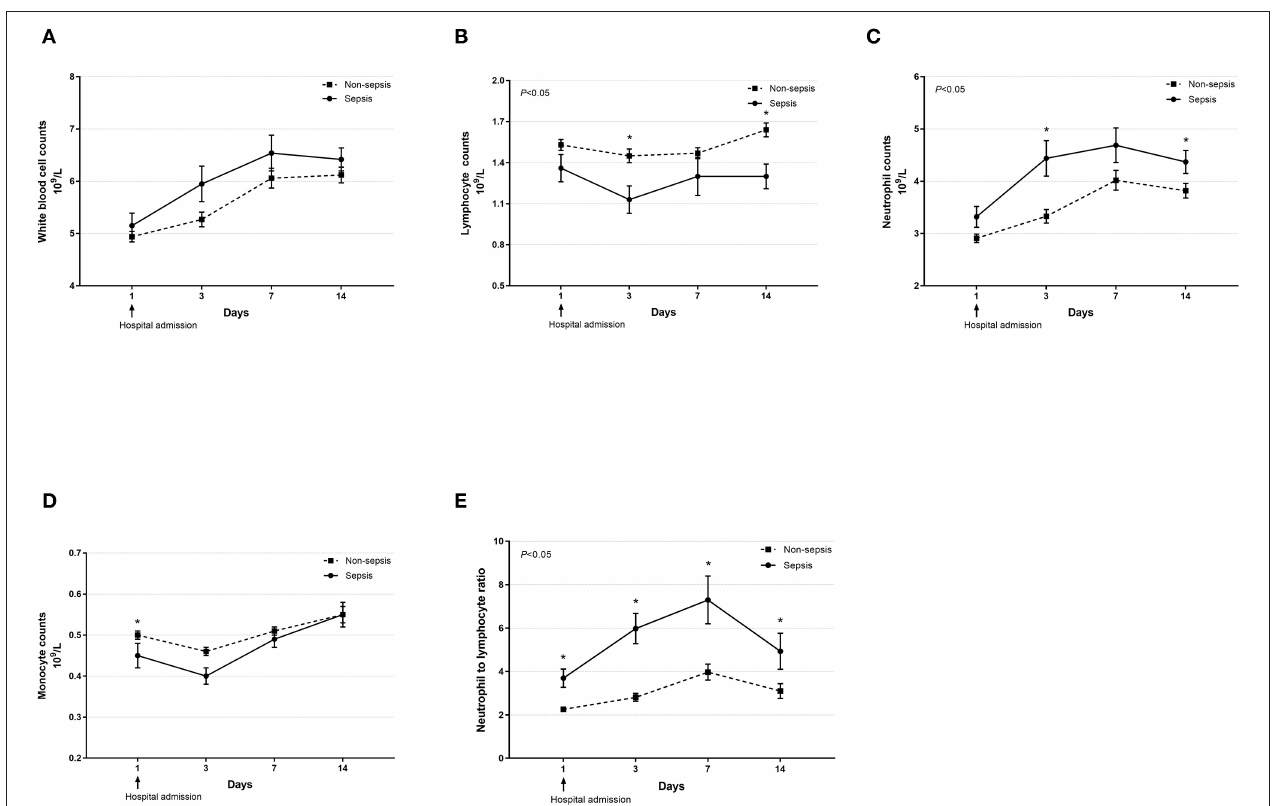
FIGURE 1 | Dynamic profiles of cell counts in septic and non-septic COVID-19 patients. The counts of white blood cells (A) , lymphocytes (B) , neutrophils (C) , monocytes (D) , and neutrophil-to-lymphocyte ratio (E) in the peripheral blood obtained from septic and non-septic COVID-19 patients were monitored and compared on days 1, 3, 7, and 14 after hospital admission. Data were presented as mean ± SEM. * P < 0.05, septic patients vs. non-septic patients. Results were tested for significance by using a general linear model with corrections for repeated measures.